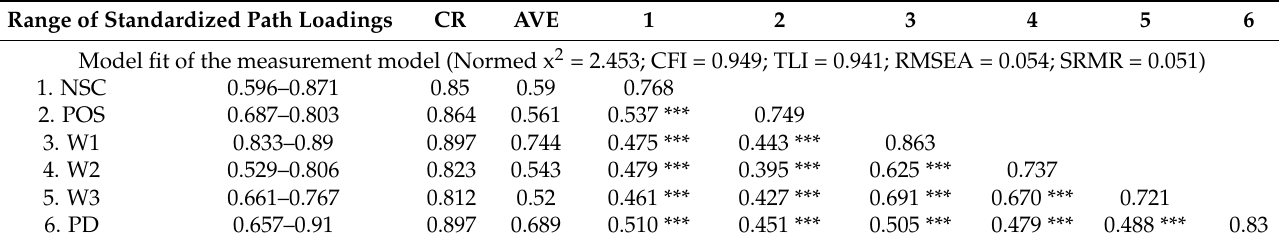
Table 3. Results of construct reliability and validity. Range of Standardized Path Loadings CR